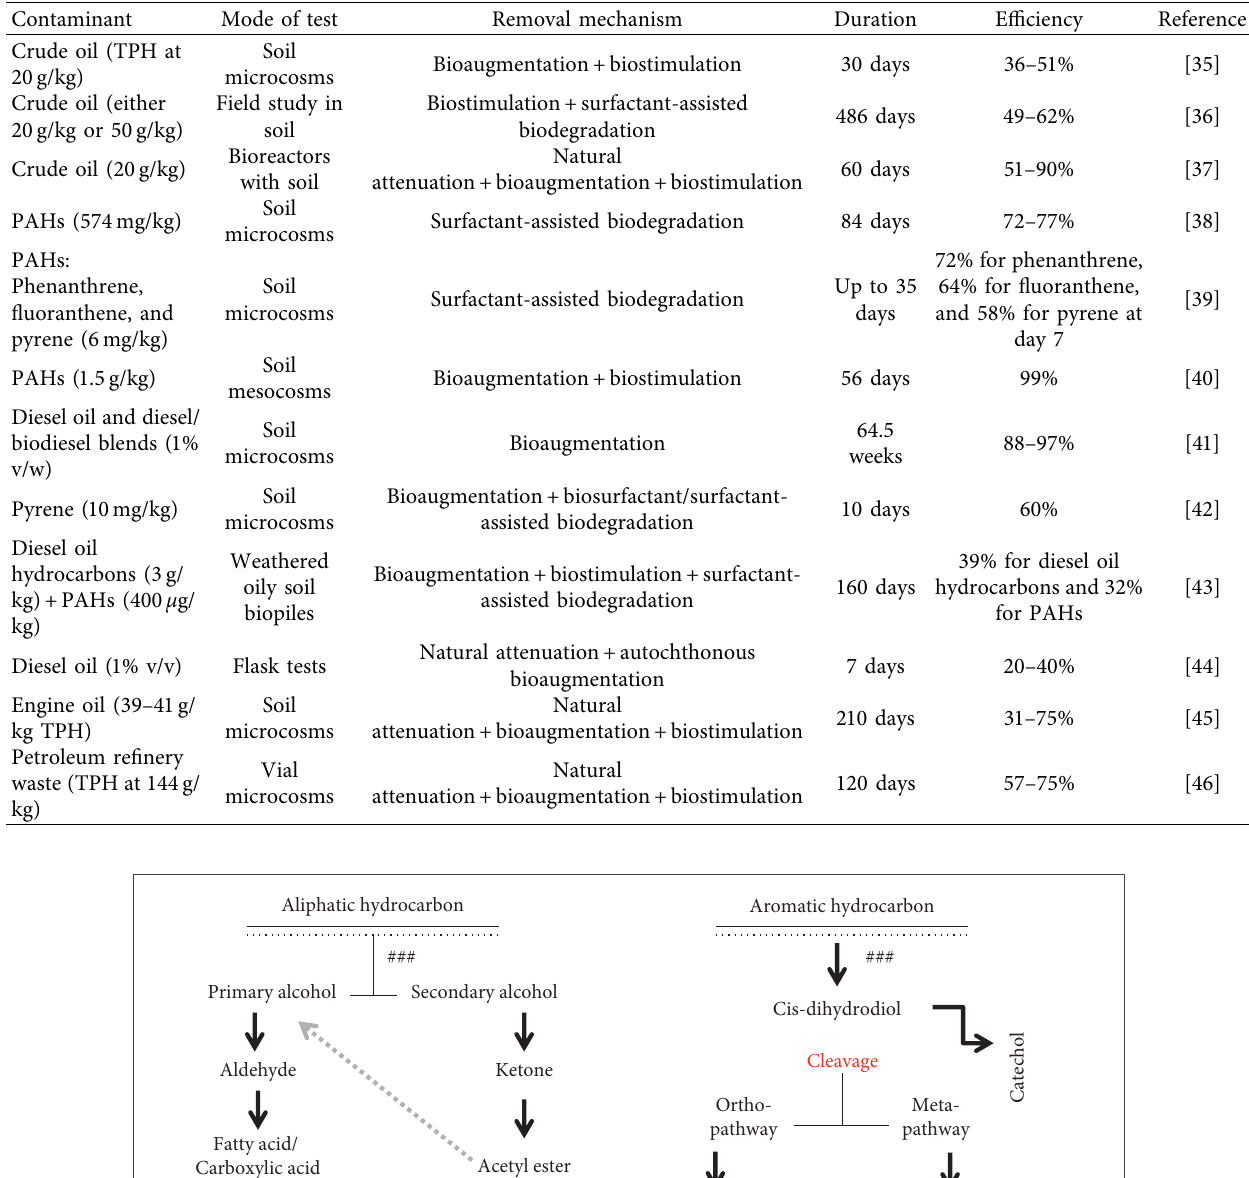
Table 1: Overview of strategies and mechanisms employed for bioremediation of hydrocarbon.